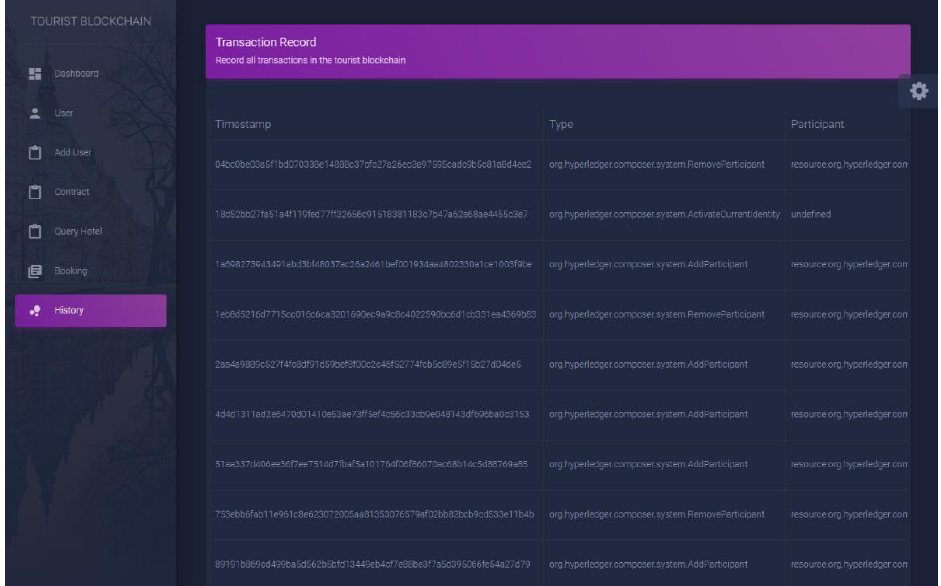
Figure 23. Screenshot of the transaction record dashboard.